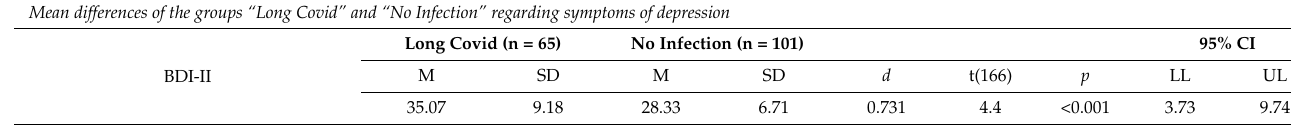
Table 4. Mean differences of the groups “Long Covid” and “No